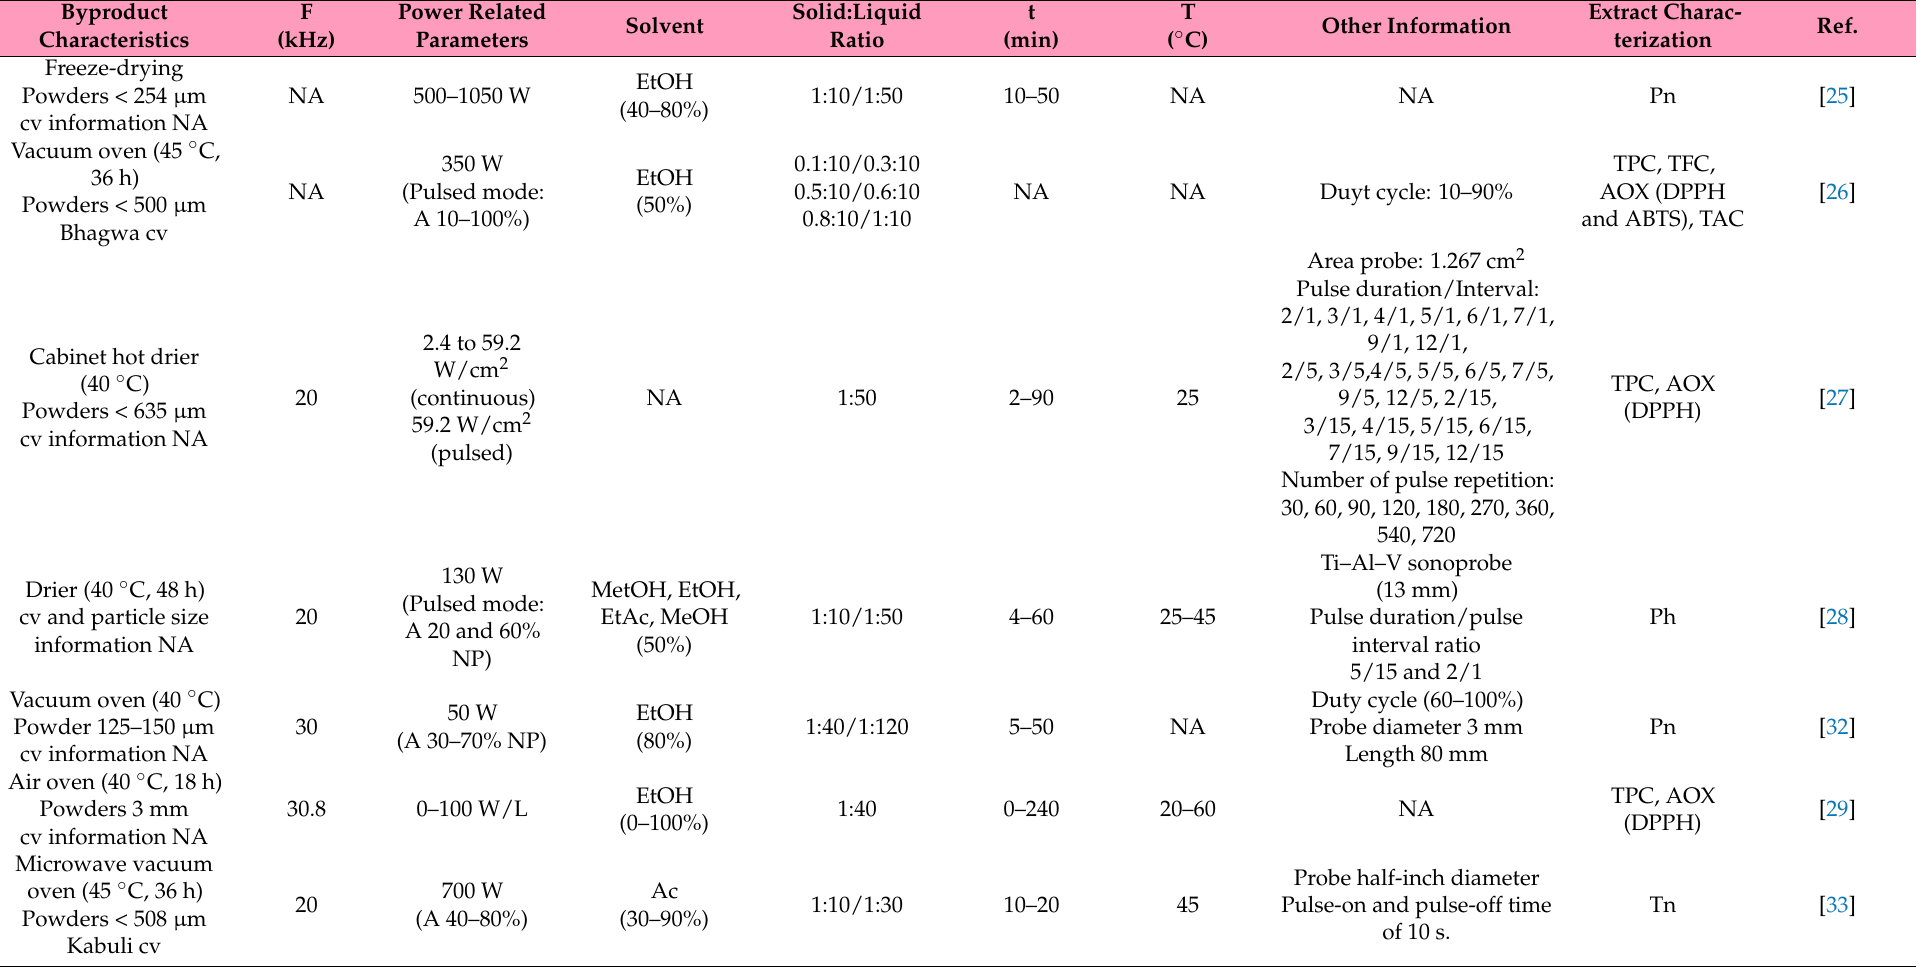
Table 1. Ultrasound conditions (frequency, power parameters, solvent, time, temperature) for the extraction of bioactive compounds from pomegranate